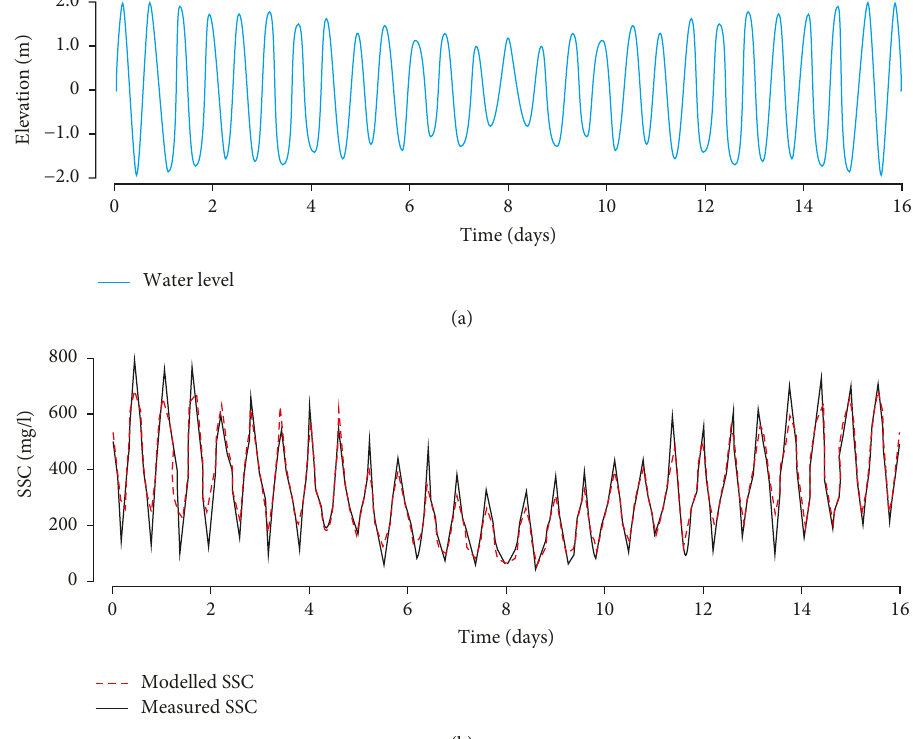
Figure 7: Time series of (a) measured water level and (b) SSC (continuous) and predicted SSC from a calibrated cohesive sediment